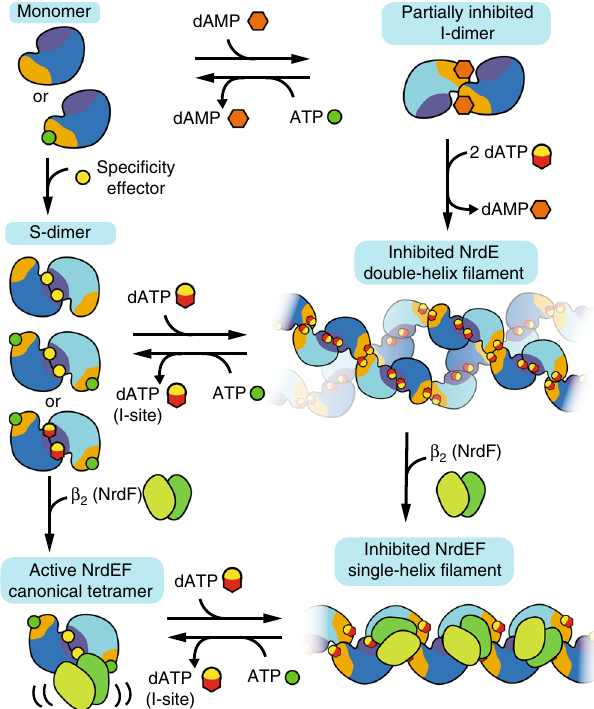
Fig. 6 A model for the overall allosteric regulation of B. subtilis RNR. Without nucleotides, NrdE is a monomer, but dAMP and dATP can bind the I-site and induce a partially inhibited I-dimer. Addition of speci fi city effectors instead induces the monomer to form an S-dimer. When speci fi city effectors (including dATP) bind to the I-dimer, they induce formation of an inhibited double-helical NrdE fi lament composed of alternating S-dimer and I-dimer interfaces. NrdF competes for the NrdE double-helical interface, and thus NrdF binding leads to the dissociation of the NrdE double-helix into individual helical structures. NrdF binds to the helical interior of the NrdE fi lament, leading to an inter-subunit gap and positional con fi nement that prevent NrdF from accessing NrdE for